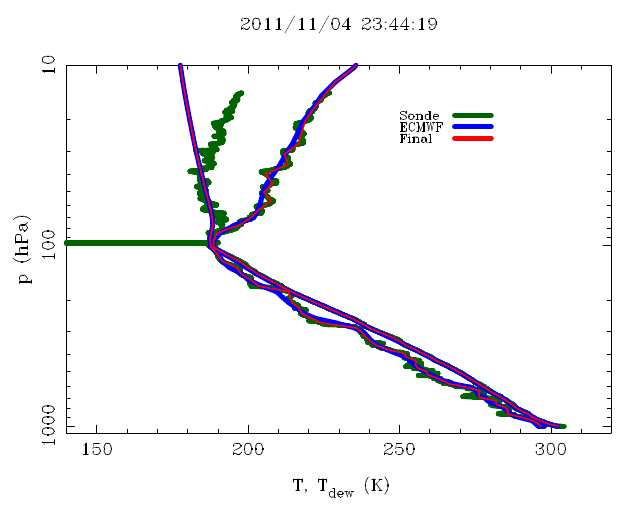
Figure 2. Individual sample of a raw GRUAN sonde (green), the ECMWF profile (blue) and the final profile after pre-processing be- fore being fed as input to LBLRTM (red). The red, green and blue lines to the right show the temperature profiles, while the ones to the left show the humidity profiles represented as dew point tem-